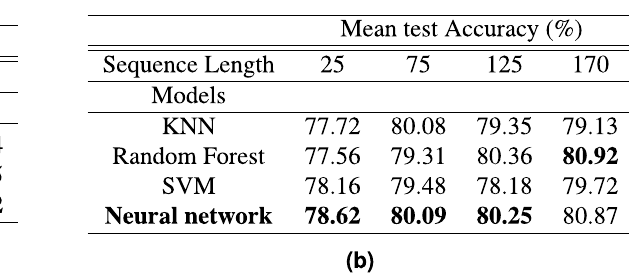
Table 1. Accuracy analysis for multiple models and sequence lengths. (a) Accuracy analysis for dataset 1. (b) Accuracy analysis for dataset 2. Highest accuracy values are given in